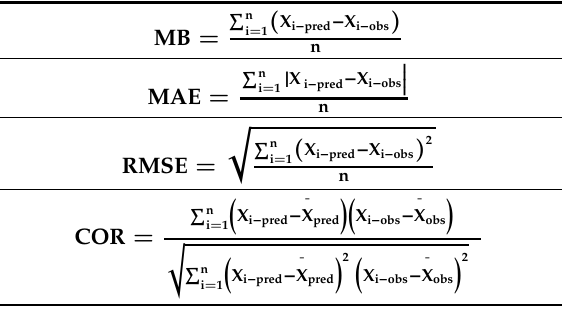
Table A1. Statistical indexes formulas for predicted (pred) and observed (obs) values.